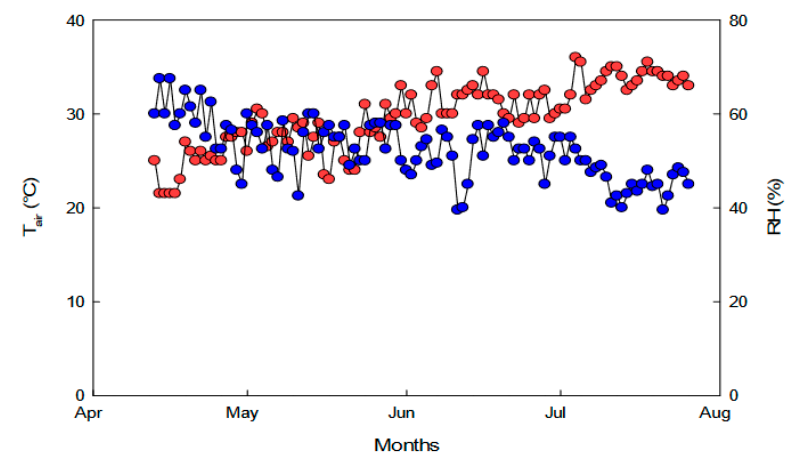
Figure 6. Daily average air temperature (red circles) and relative humidity (blue circles) inside the greenhouse during the experimental period.